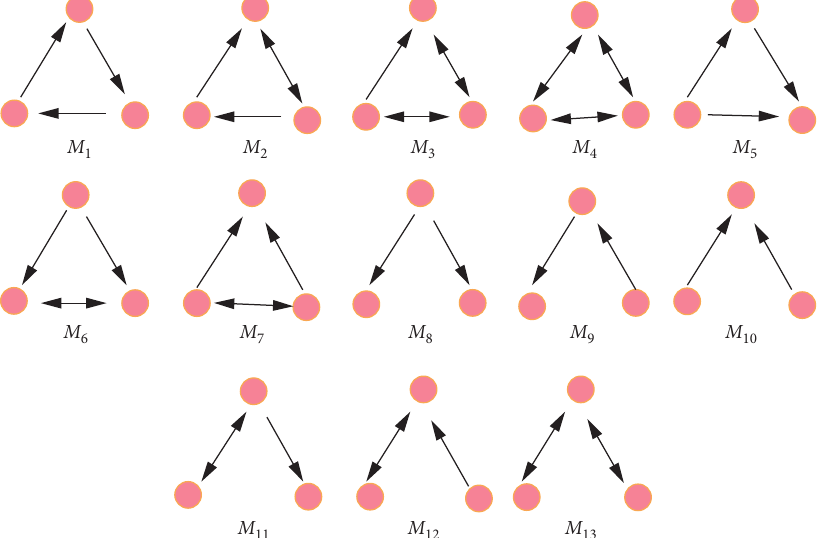
Figure 3: Triangle